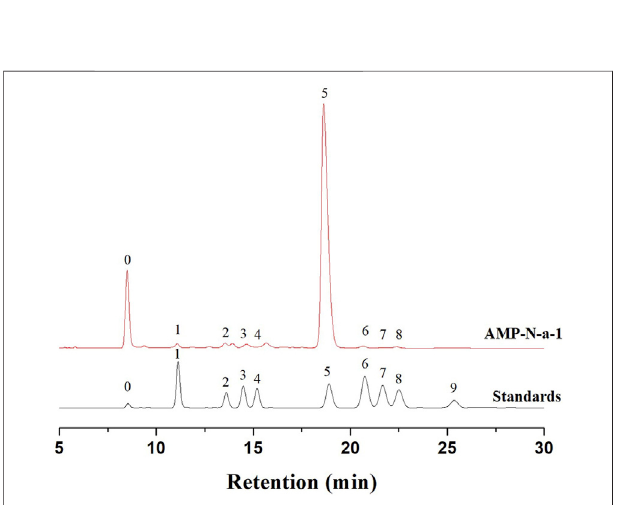
FIGURE 1 | Chromatograms of nine PMP-derivative monosaccharide standards (0-PMP, 1-Man, 2-Glca, 3-Rha, 4-Gala, 5-Glc, 6-Gal, 7-Xyl, 8-Ara, and 9-Fuc) and